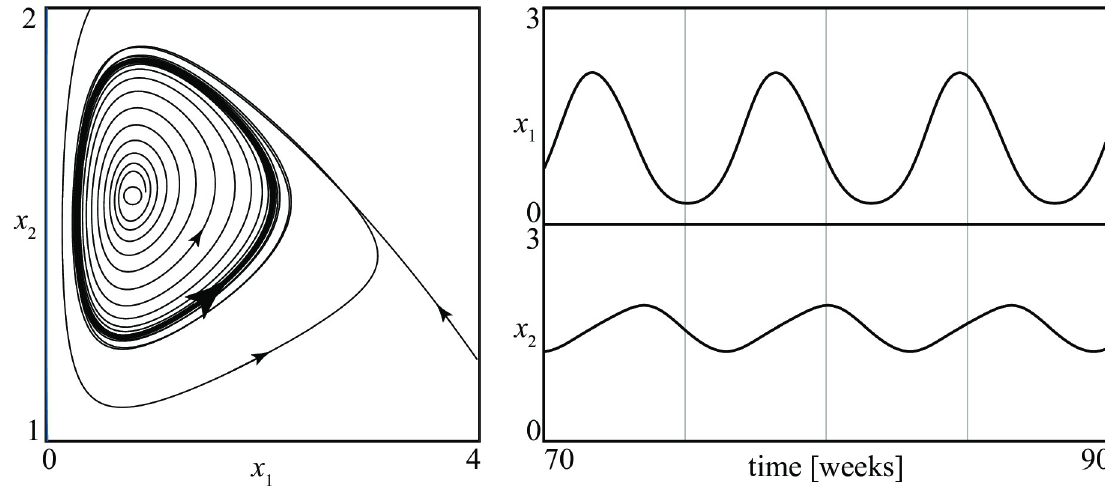
Fig 6. An example of periodic stalemate in a D—A